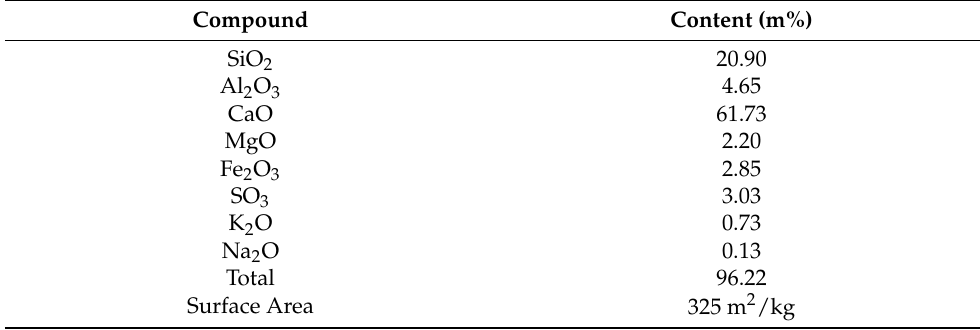
Table 1. Composition of the P I 42.5 cement used in this